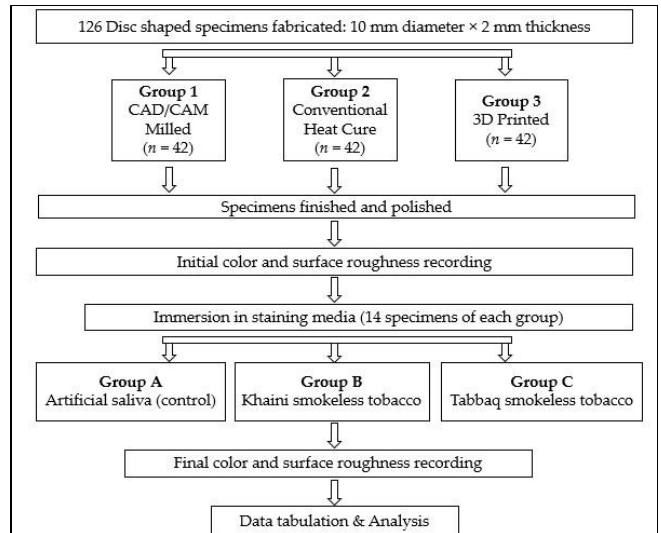
Figure 6. A flowchart depicting the study design.